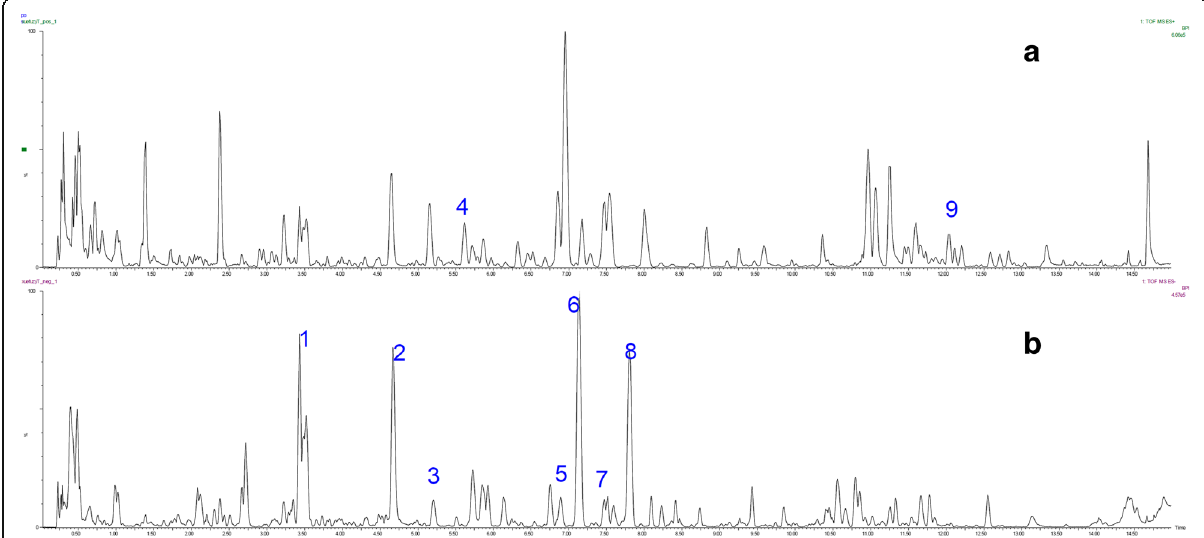
Fig. 1 Typical total ion chromatograms obtained from XFZY in the positive a and negative modes b . Hydroxysafflor yellow A (1), Paeoniflorin (2), Ferulic acid (3), Liquiritoside (4), Anhydrosafflor yellow B (5), Naringin (6), Hesperidin (7), Neohesperidin (8), and Glycyrrhizic acid (9) were identified or tentatively characterized in XFZY